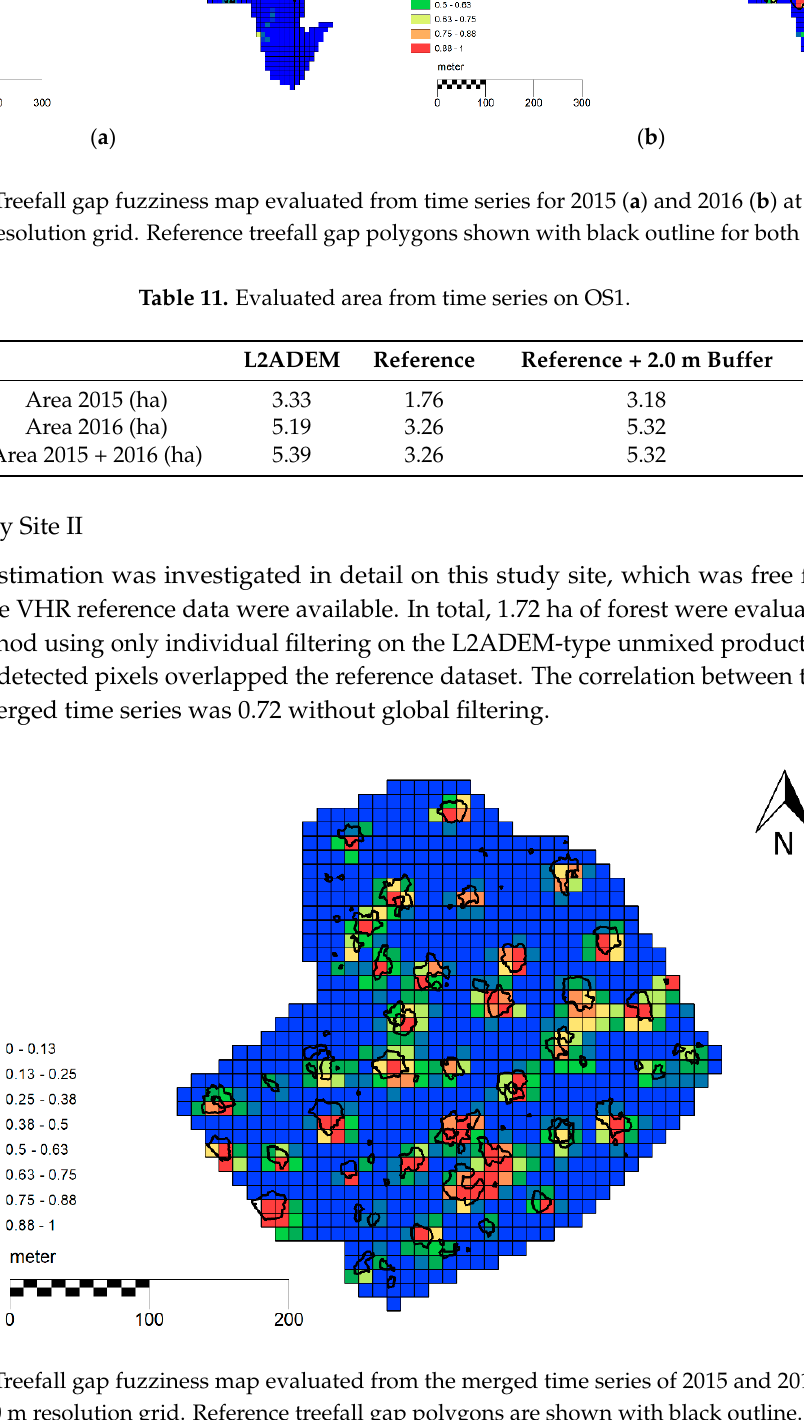
( b ) Figure 14. Treefall gap fuzziness map evaluated from 2016 at the BS on a 10 m resolution grid ( a ). Regeneration strength map of partial crown damage between 2015 and 2016 on the same 10 m resolution grid ( b ).